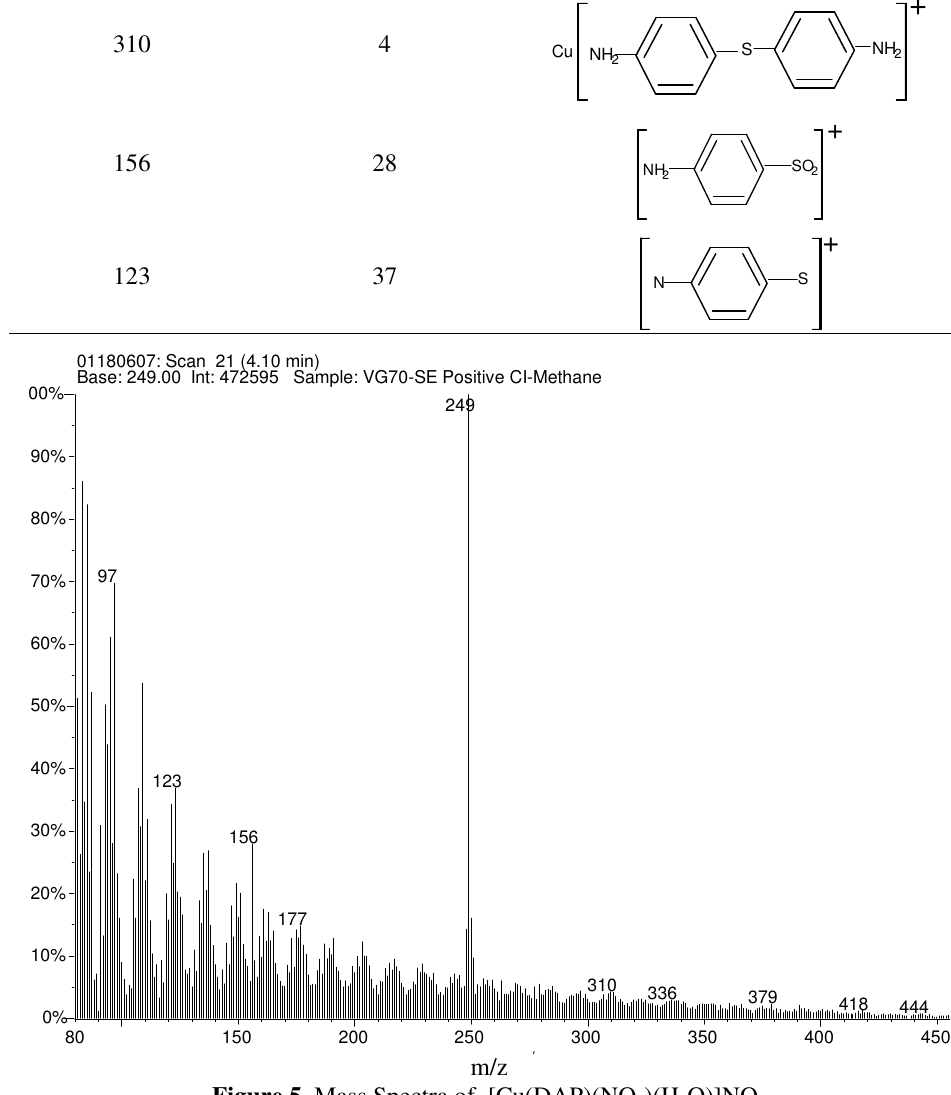
Figure 5. Mass Spectra of [Cu(DAP)(NO